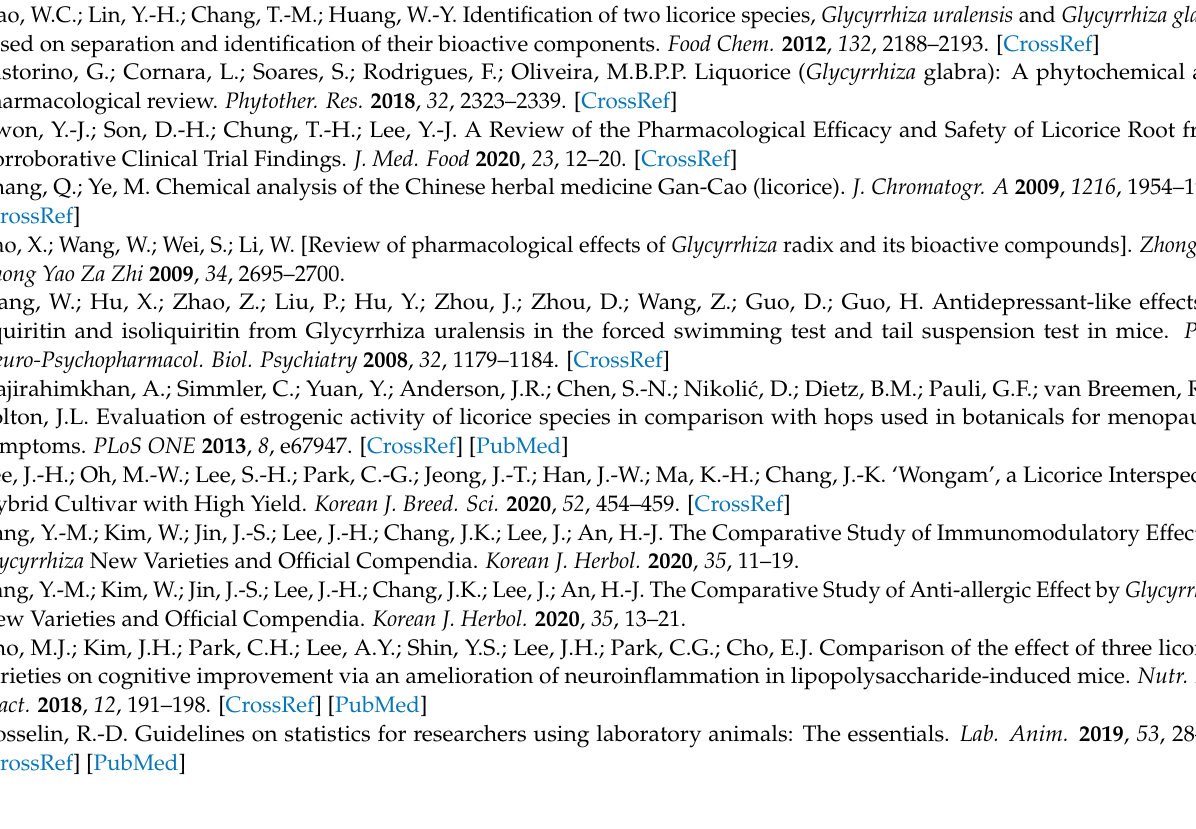
oral dose toxicity of WG in female rats, Table S6: Serum biochemical values in 4 weeks repeated oral dose toxicity of WG in male rats, Table S7: Serum biochemical values in 4 weeks repeated oral dose toxicity of WG in female rats, Table S8: Absolute and relative organ weights in 4 weeks repeated oral dose toxicity of WG in male rats, Table S9: Absolute and relative organ weights in 4 weeks repeated oral dose toxicity of WG in female rats, Table S10: Necropsy findings in 4 weeks repeated oral dose toxicity of WG in male rats, Table S11: Necropsy findings in 4 weeks repeated oral dose toxicity of WG in female